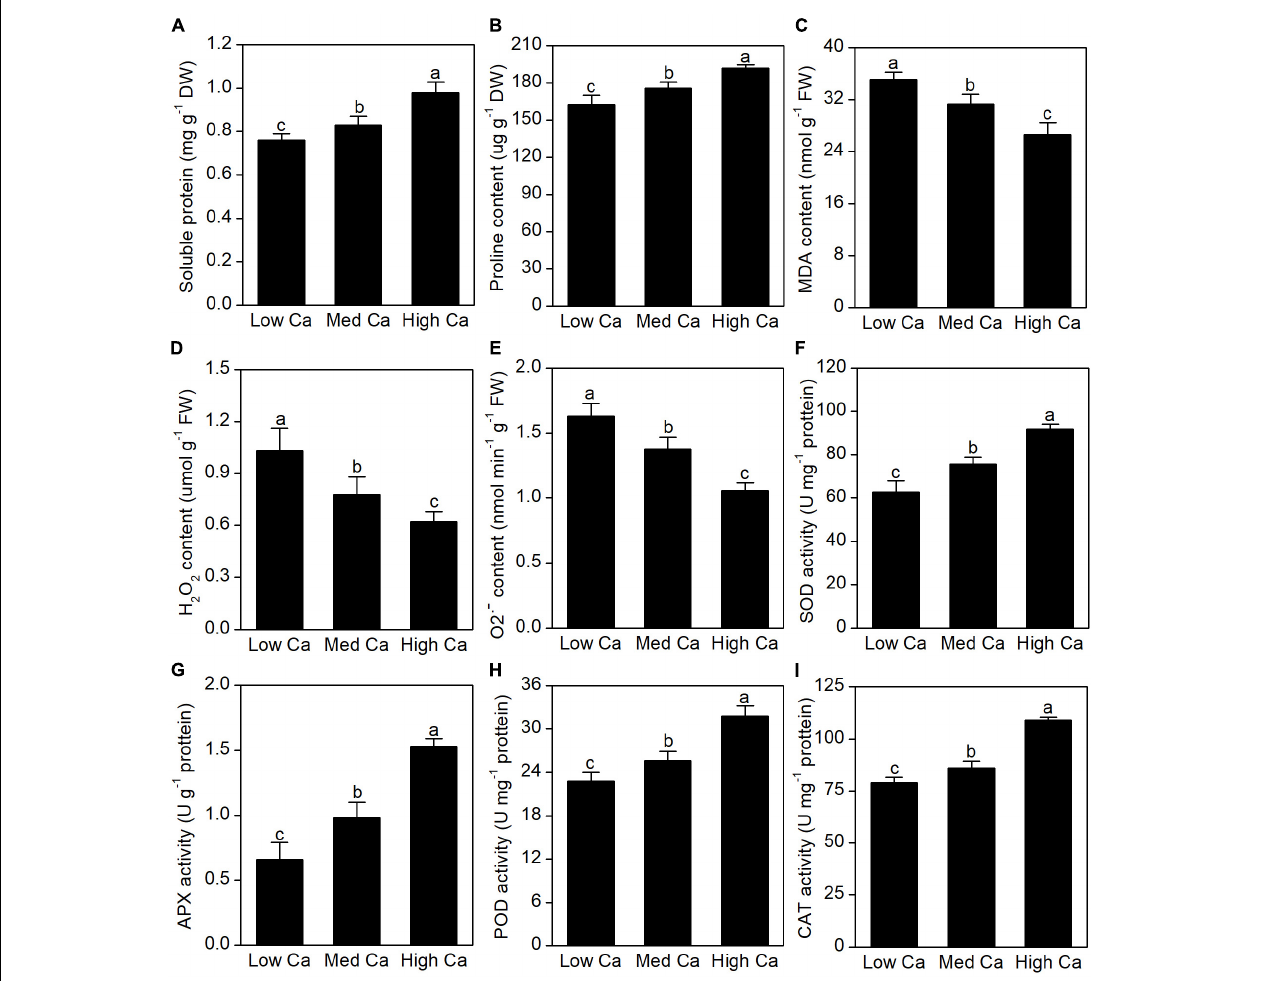
FIGURE 2 | Effects of different Ca treatments on lipid peroxidation, ROS production, and antioxidant enzyme activity under simulated AR stress in T. wallichiana var. mairei leaves. The soluble protein content (A) , proline content (B) , MDA content (C) , H 2 O 2 content (D) , O2 •− content (E) , SOD activity (F) , APX activity (G) , POD activity (H) , and CAT activity (I) . Columns labeled by different letters indicate significant differences at p <